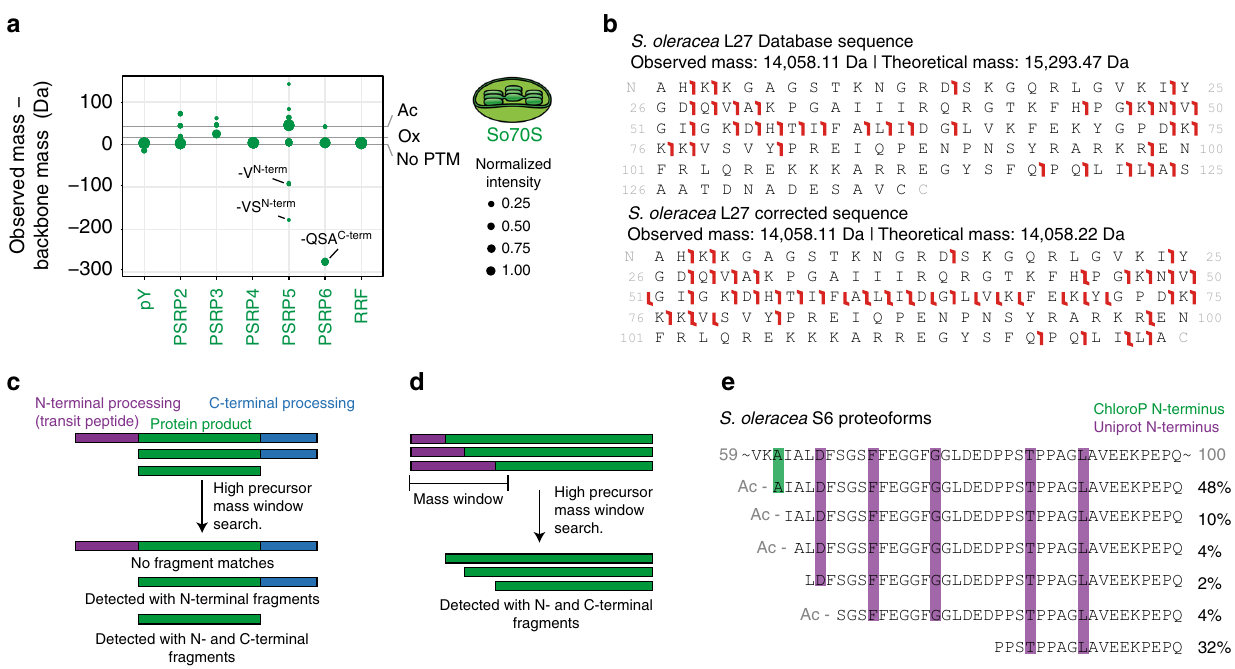
Fig. 3 Top-down analysis using high precursor mass window searches identi fi es processing of the plastid ribosomal proteins. a For the plastid-speci fi c ribosomal proteins (PSRPs) of the chloroplastic 70S ribosome, the translation factor pY and the ribosome recycling factor (RRF), several co-occurring proteoforms could be identi fi ed and quanti fi ed, resulting from post-translational modi fi cation and/or processing of the termini. In the corresponding cryo- EM structure of the chloroplastic 70S ribosome, RRF was not modelled due to absence of electron density 14 . b , c The chloroplastic ribosomal protein L27 is processed at both the N- and C-terminus and is therefore not detected through top-down sequencing when searching for the intact gene product. Corrections to either the N- or C-terminal sequence provides fragment ions from the C- and N-terminus, respectively, as long as the precursor mass window is larger than the mass of the sequence correction. d , e In a similar way, variable processing at the N-terminus of the chloroplastic ribosomal protein S6 could be detected by using C-terminal fragments to fi rst identify which intact masses belong to S6 and subsequently correct the sequence until the theoretical and measured masses